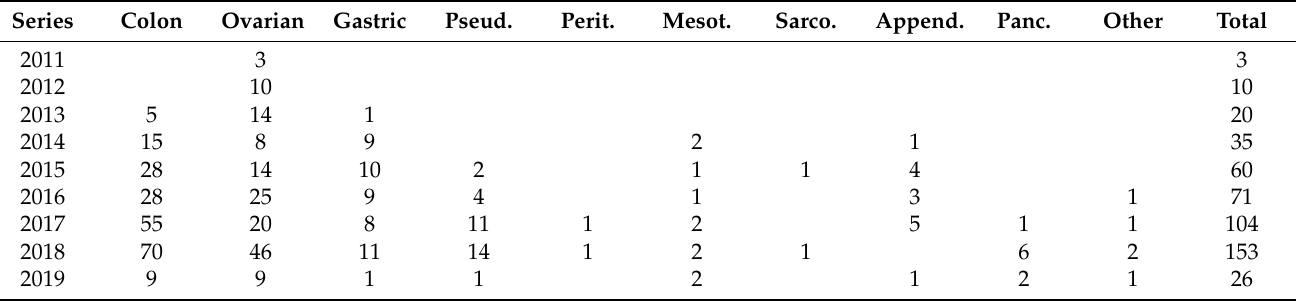
Table 1. Participating hospitals, patients provided (yearly tumoral histology) and evolution over time of the number of procedures. (Pseud: pseudomyxoma. Perit: primary peritoneal. Mesot: